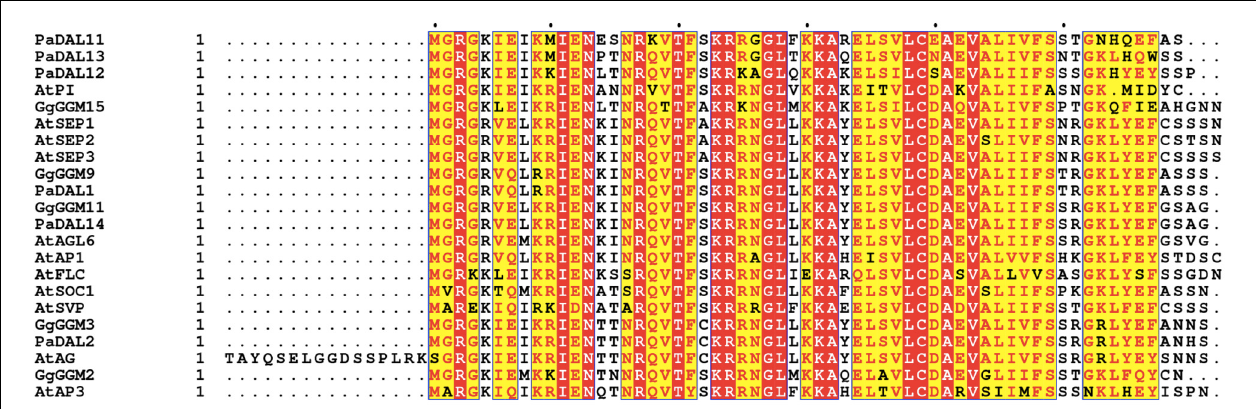
FIGURE 4 | Sequence alignment of MADS TFs M-domain. Aligned M-domain amino acid sequences of A. thaliana SEP3, SEP1, SEP2, AP3, PI, AP1, AG, AGL6, SOC1, SVP, and FLC; the gymnosperm Gnetum gnemon GGM2, GGM15 (AP3/PI-like), GGM3 (AG-like), and GGM9, GGM11 (AGL6-like); and the gymnosperm Picea abies DAL11, DAL12, DAL13 (AP3/PI-like), DAL2 (AG-like), and DAL1, DAL14 (AGL6-like) proteins. Sequence numbering is indicated on the left, with every tenth residue marked by black dots above the sequences. Highly conserved regions are boxed, with similar residues represented in red against a yellow background, invariant residues represented against a red background and non-conserved residues indicated in black.